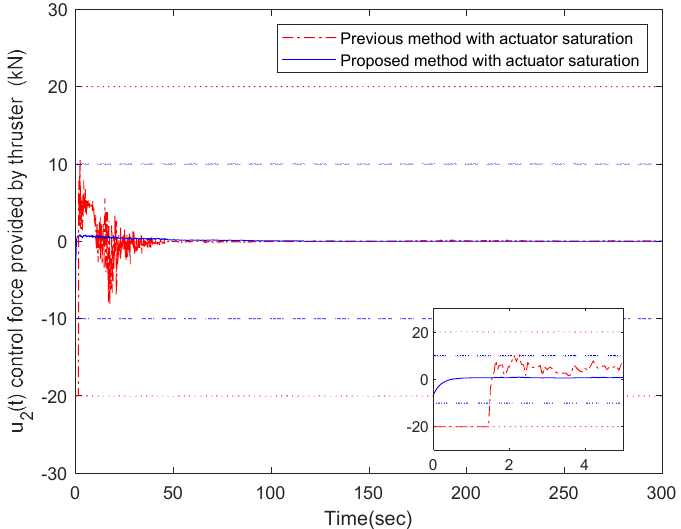
Figure 11. The responses of u 2 ( t ) compared with [29].